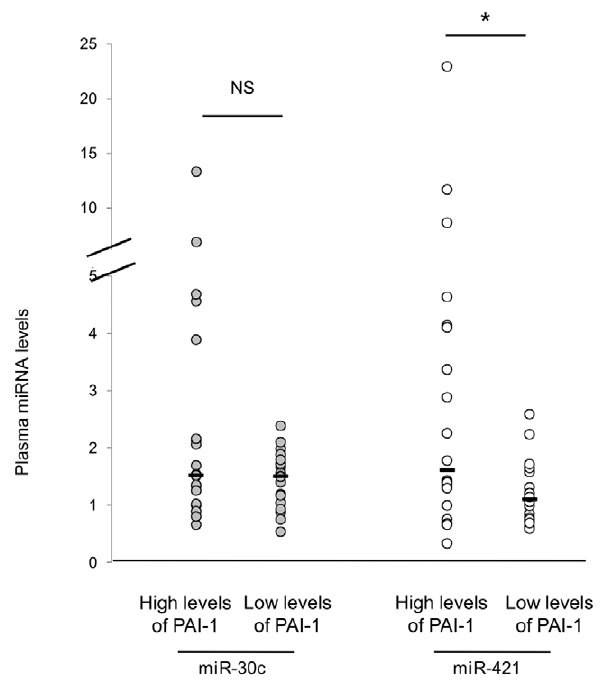
Figure 5. Plasma levels of miR-421 and miR-30c in plasma samples of venous thrombosis patients. MiR-421 and miR-30c were detected by qRT-PCR in plasma samples from two groups of 20 patients either with low (1.6 + / 2 1 ui/ml) or high (40.5 + / 2 13 ui/ml) PAI- 1 plasma levels. 40 fmol of synthetic cel-miR (39/54/238) were used for normalization. Median values are shown in black line (*: p ,